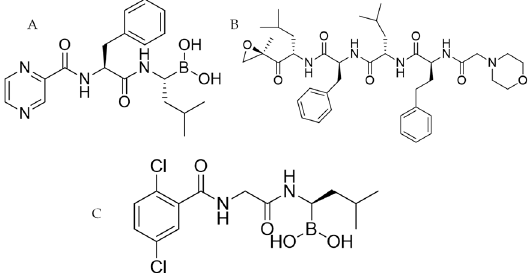
Figure 1. 2D structure of the FDA-approved proteasome inhibitors BTZ (A), CFZ (B) and Ixazomib (C).